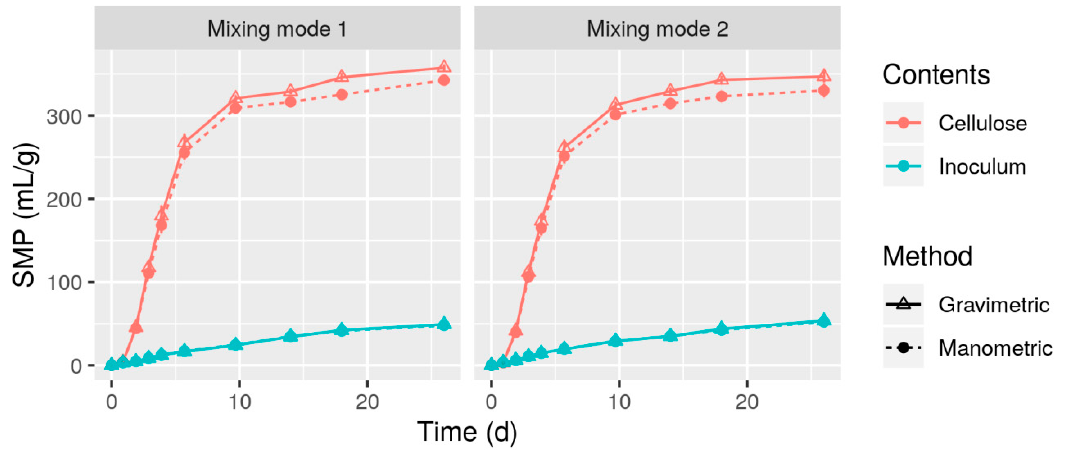
Figure 3. Gravimetric and manometric specific methane production (SMP) expressed in mL of CH 4 per g VS for BMP tests with mixing mode 1 ( left ) and 2 ( right ). Each point shows an average value ( n = 5) and vertical lines show standard deviation (usually smaller than plotting symbol).